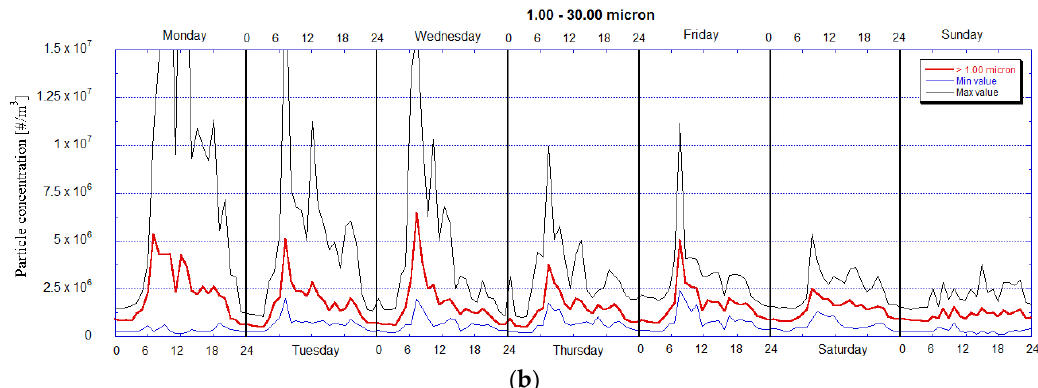
Figure 11. Weekly trend of the PM mean number concentration, the red line, monitored in the bus terminal of Collemaggio parking site, L’Aquila, in the period June 2016–August 2016. Two granulometric sizes are shown: ( a ) 0.30–0.99 µm, ( b ) 1.00–25.00 µm. Blue and black lines indicate the minimum and maximum values monitored, respectively. Analysis of hourly averages. Data collected by OPC TSI .